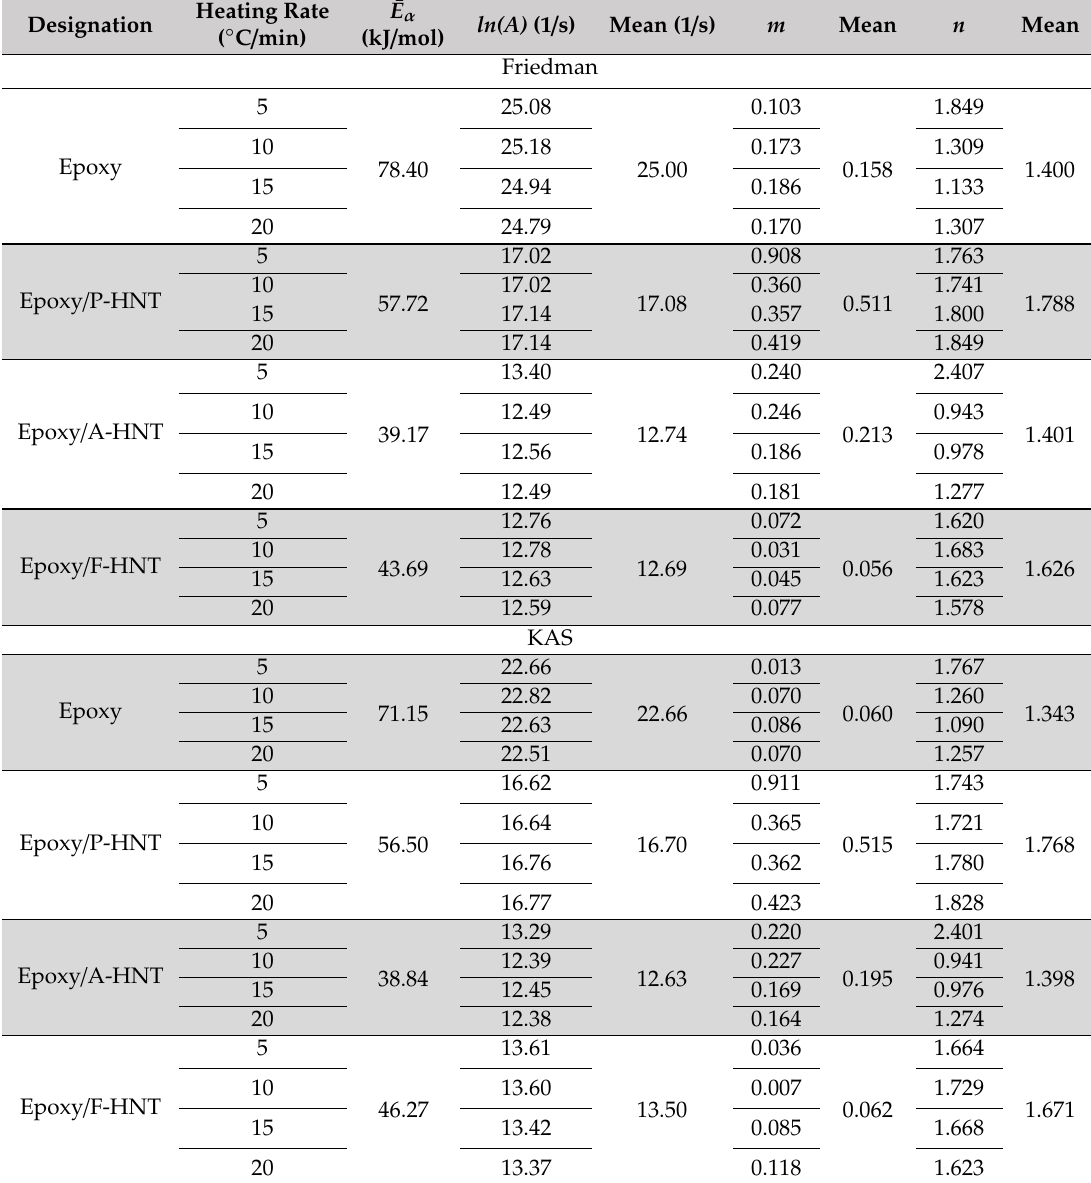
Table 2. The kinetic parameters evaluated for the curing of pristine epoxy resin and its nanocomposites based on Friedman and KAS models at di ff erent heating